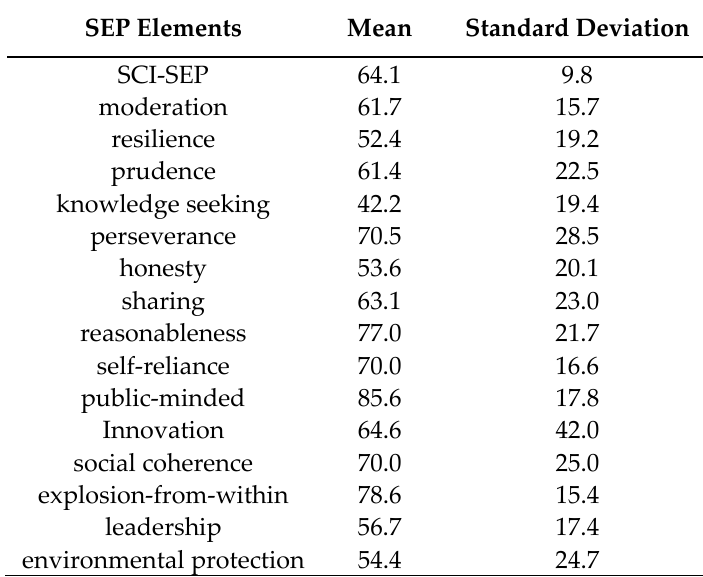
Table 1. SCI-SEP and its element scores, Non-municipal Northeast